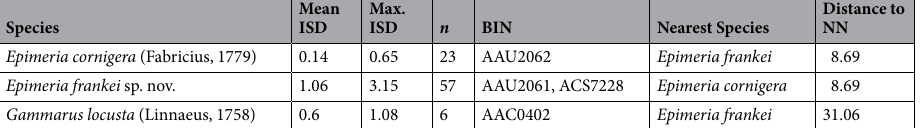
Table 1. K2P distances between Epimeria cornigera , Epimeria frankei sp. nov., and Gammarus locusta . Divergence values were calculated for all sequences studied, based on the Nearest Neighbor Summary implemented in the Barcode Gap Analysis tool provided by the Barcode of Life Data System (BOLD). Align sequencing option: BOLD aligner (amino acid based HMM), ambiguous base/gap handling: pairwise deletion. ISD = intraspecific distance. BINs are based on the barcode analysis from